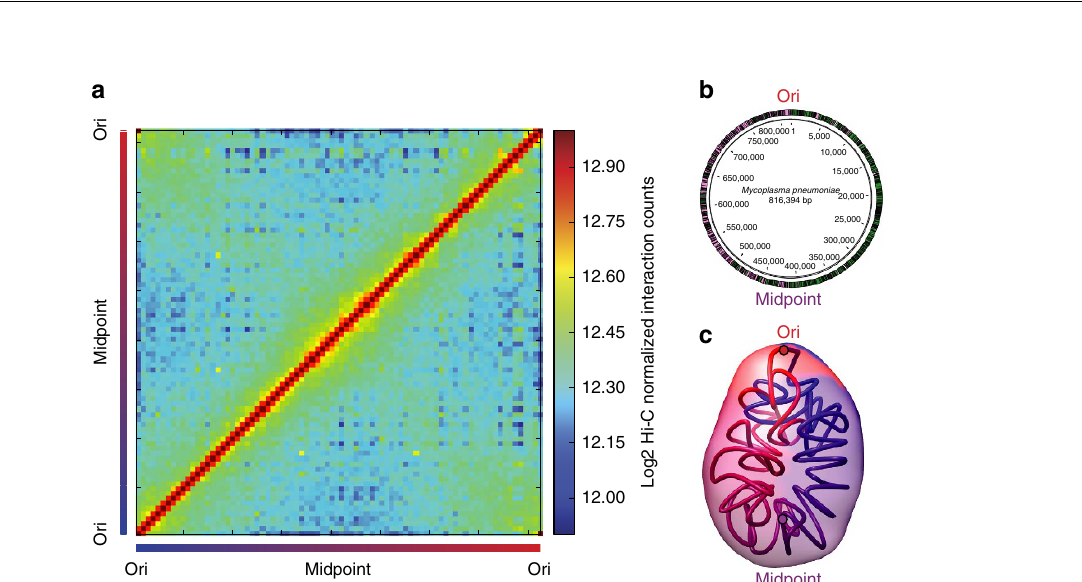
Figure 1 | Hi-C matrix and 3D models of the M. pneumoniae chromosome reveal a global symmetry with Ori and midpoint located at the two opposite poles. ( a ) Normalized HpaII Hi-C contact map of M. pneumoniae, in stationary phase at a 10kb resolution. The frequency of interactions between a given pair of bins is found at the intersection of the row and column corresponding to those bins. The colour of the contact map, from blue to red, indicates the log2 contact frequency. The bar underneath indicates position along the genome, with Ori being located at a genome coordinate of 0 and midpoint located at B 400kb. ( b ) Simplified genomic map showing the gene distribution across the chromosome, with black lines delimitating the genes. The colour indicates the strand position, with pink being the (cid:2) strand and green the þ strand. ( c ) A 3D density map representation of the 516 superimposed model structures from the first cluster of M. pneumoniae genome models. A central model, referred to as the centroid, is the model that is closest to the mean x,y,z coordinates of all the other models. This centroid is shown as a coloured tube starting with particle 1 in blue and ending with particle 82 in red, and uses the same colour code as the bar in a . The Ori and midpoint particles are highlighted with red and purple circles, respectively. The lighter colour represents the space occupied by all the models in the cluster, that is, the variability across the cluster.